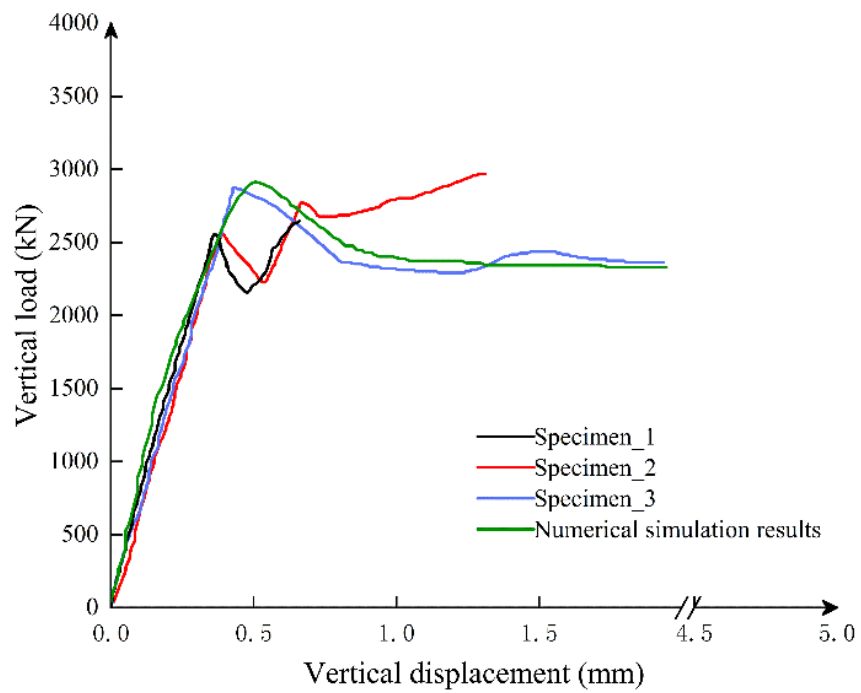
Figure 11. The load–displacement curve of a test piece for the straight bolt and rectangular hand hole joint.